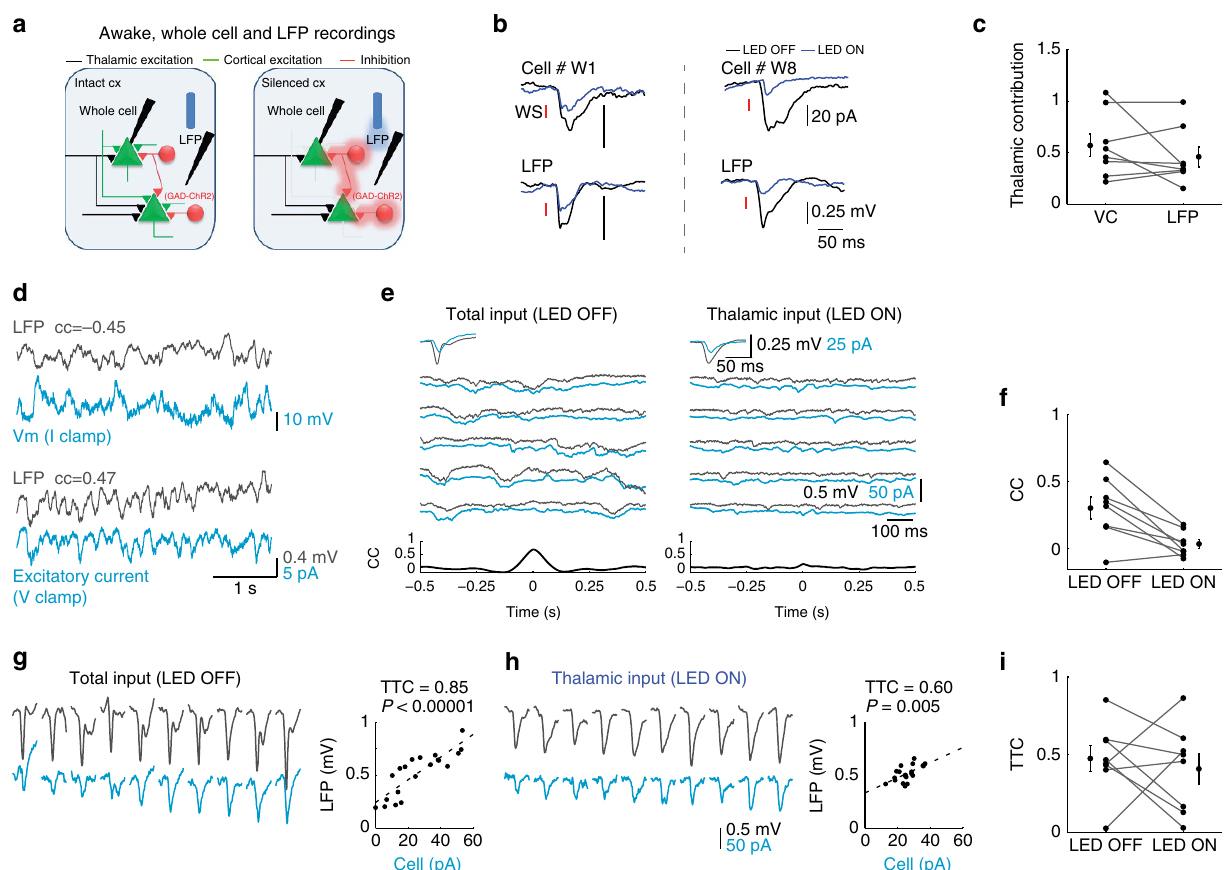
Figure 6 | Ongoing and whisker-evoked correlations in awake mice are not determined by thalamic inputs. ( a ) Schematic illustration of whole cell and LFP paired recordings in awake mice. ( b ) Average of paired recordings showing mean whisker-evoked EPSCs and LFP responses recorded from two animals. ( c ) Population data and mean peak EPSCs and the corresponding LFP response under LED OFF and LED ON conditions. ( d ) Simultaneous whole cell and LFP recordings in L4 during ongoing activity when the cell was recorded in current clamp and voltage clamp (at the reversal potential of inhibition) modes. ( e ) Example traces of ongoing excitatory currents in a L4 cell and the corresponding nearby LFP signal that was recorded simultaneously during LED OFF and LED ON conditions. Upper insets, average whisker-evoked EPSCs and LFP under the same conditions. Lower insets, cross-correlation between the cell and the LFP. ( f ) Population CC values for L4–LFP pairs n ¼ 8, P ¼ 0.01, Wilcoxon signed rank test). ( g , h ) TTC EL of EPSC–LFP paired recordings during LED